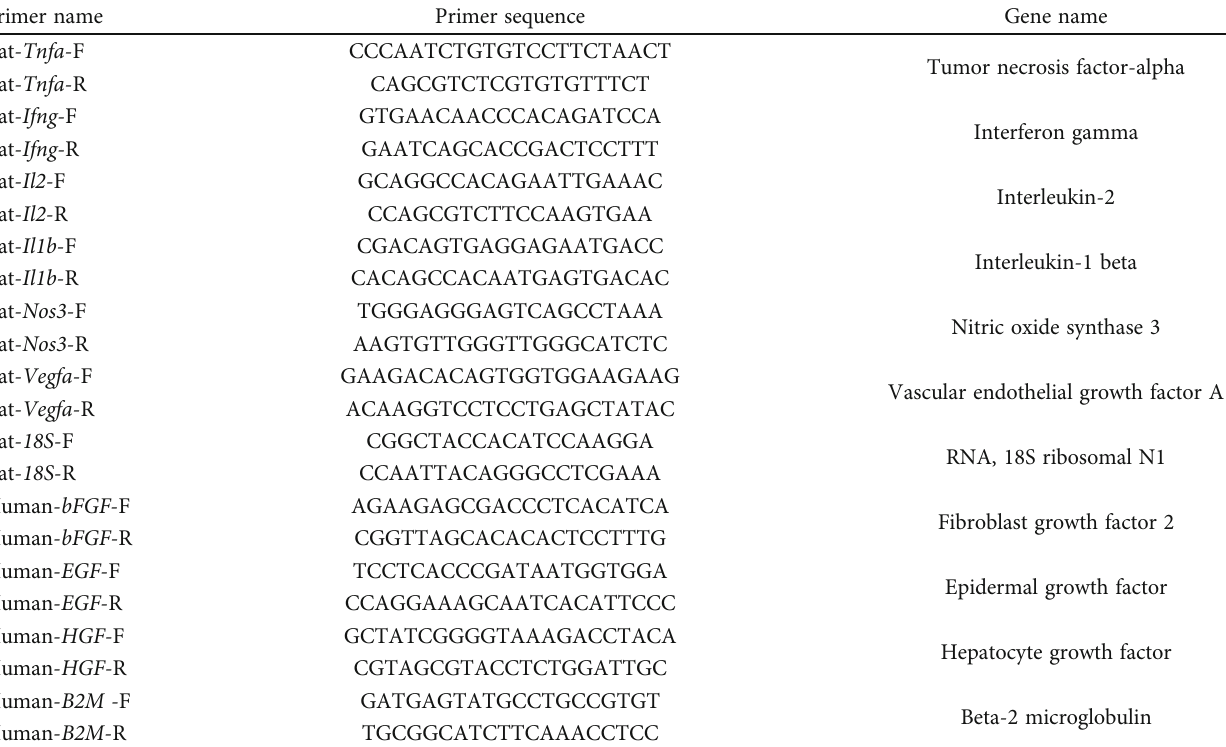
Table 1: Primer sequences.